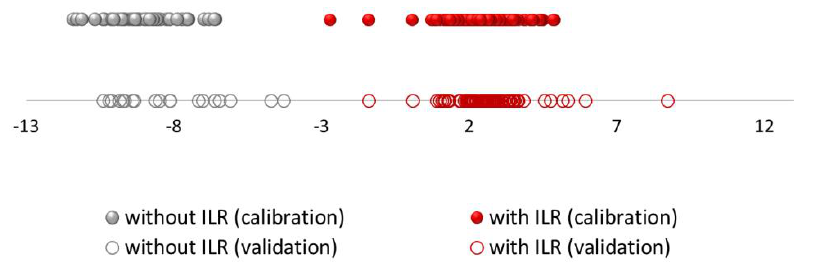
Figure 2. Discriminant scores obtained by LDA for all the burned samples using headspace–mass spectroscopy electronic nose (HS-MS) data (the red colour corresponds to samples with ignitable liquid residues (ILR) and the grey colour without ILR); The dots represent the samples in the training set and the circles represent the samples in the validation set.